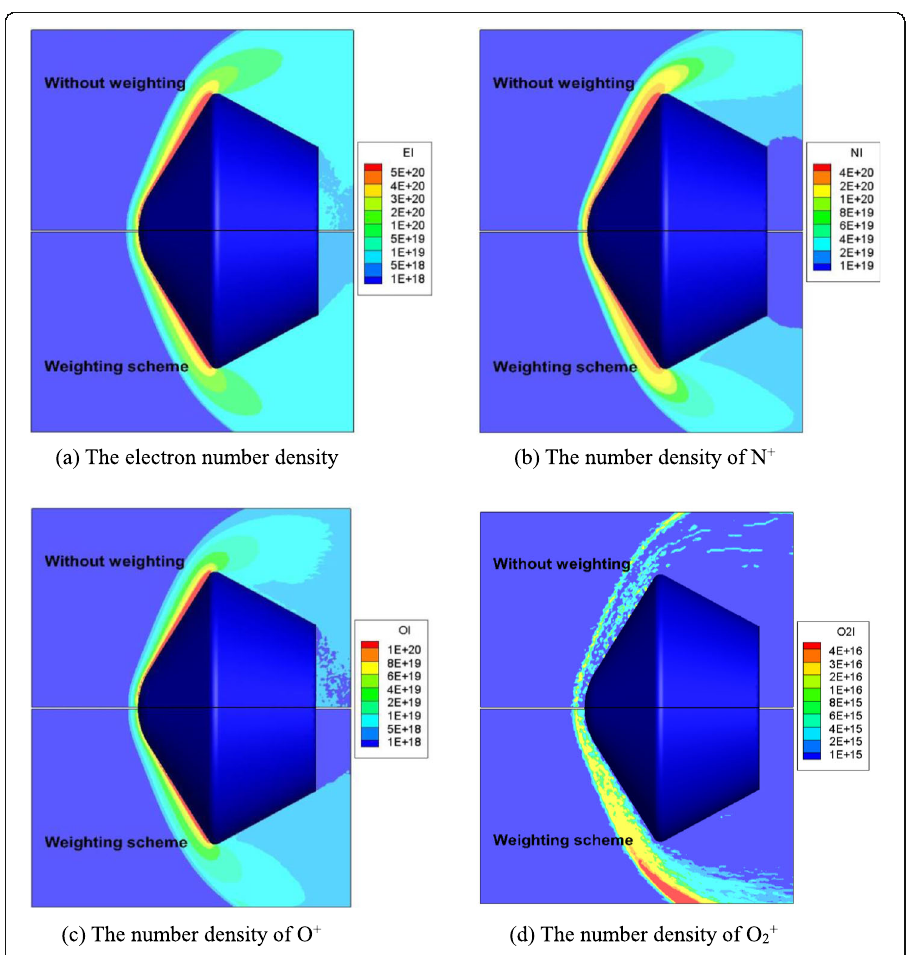
Fig. 12 The number densities for electron, N + , O + and O 2+ around Stardust at H = 80km, V ∞ = 12.8 k m/s. a The electron number density. b The number density of N + . c The number density of O + . d The number density of O